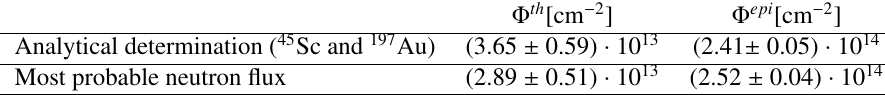
Table 1. Values of the production rates of the four monitors.